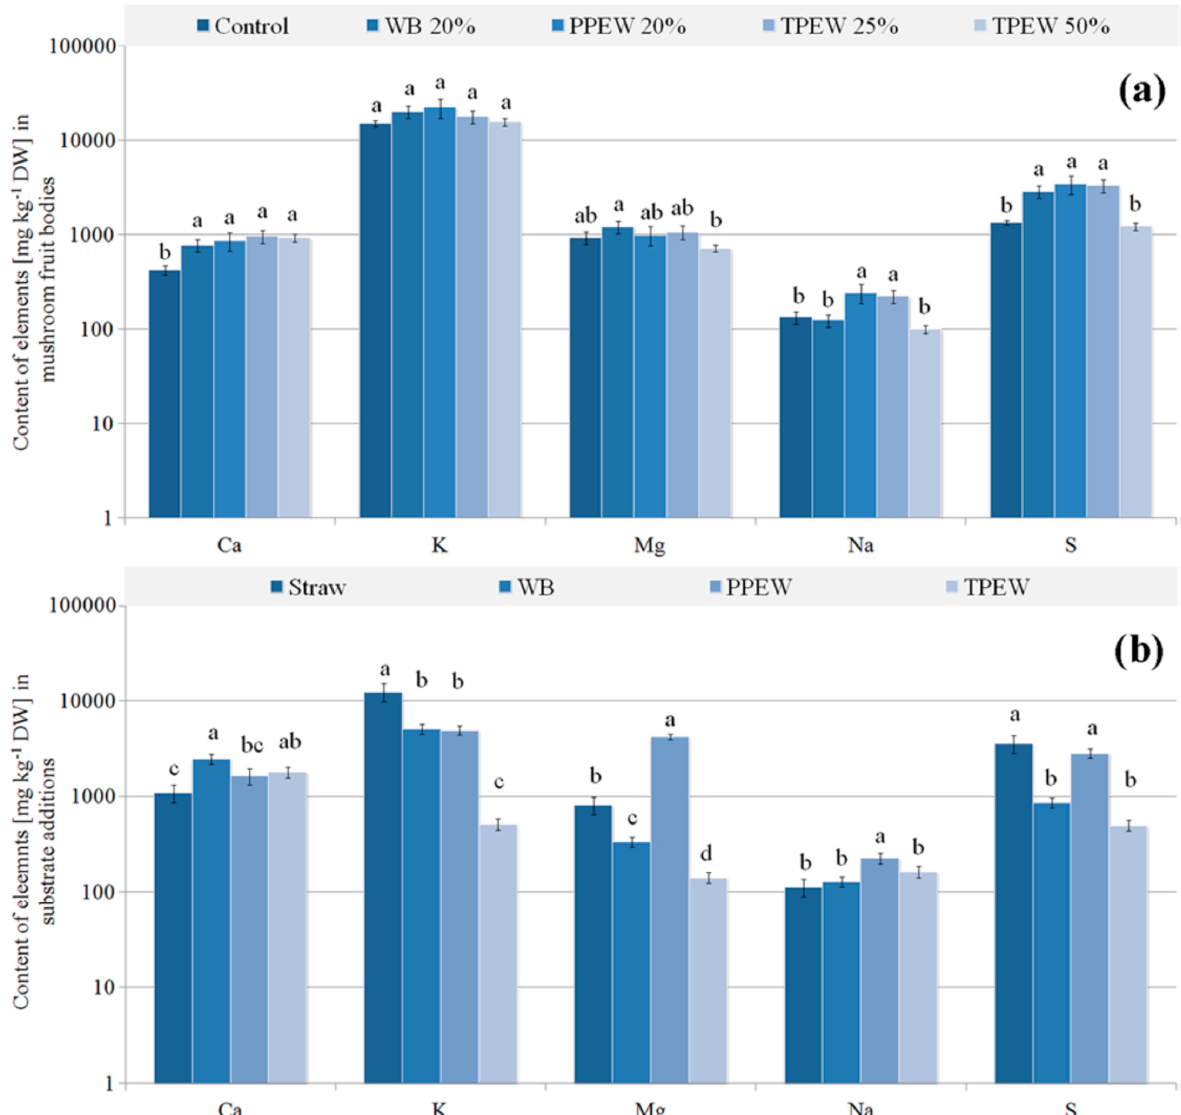
Figure 2. Content of nutritional elements (mg kg − 1 DM) in Pleurotus citrinopileatus fruit bodies ( a ) and particular additions included to substrate ( b ). Mean values ( n = 3); identical superscripts ( a–d ) denote no significant ( p < 0.05) difference between mean values in columns according to Tukey’s HSD test (ANOVA) for mushrooms growing at particular substrates. WB—